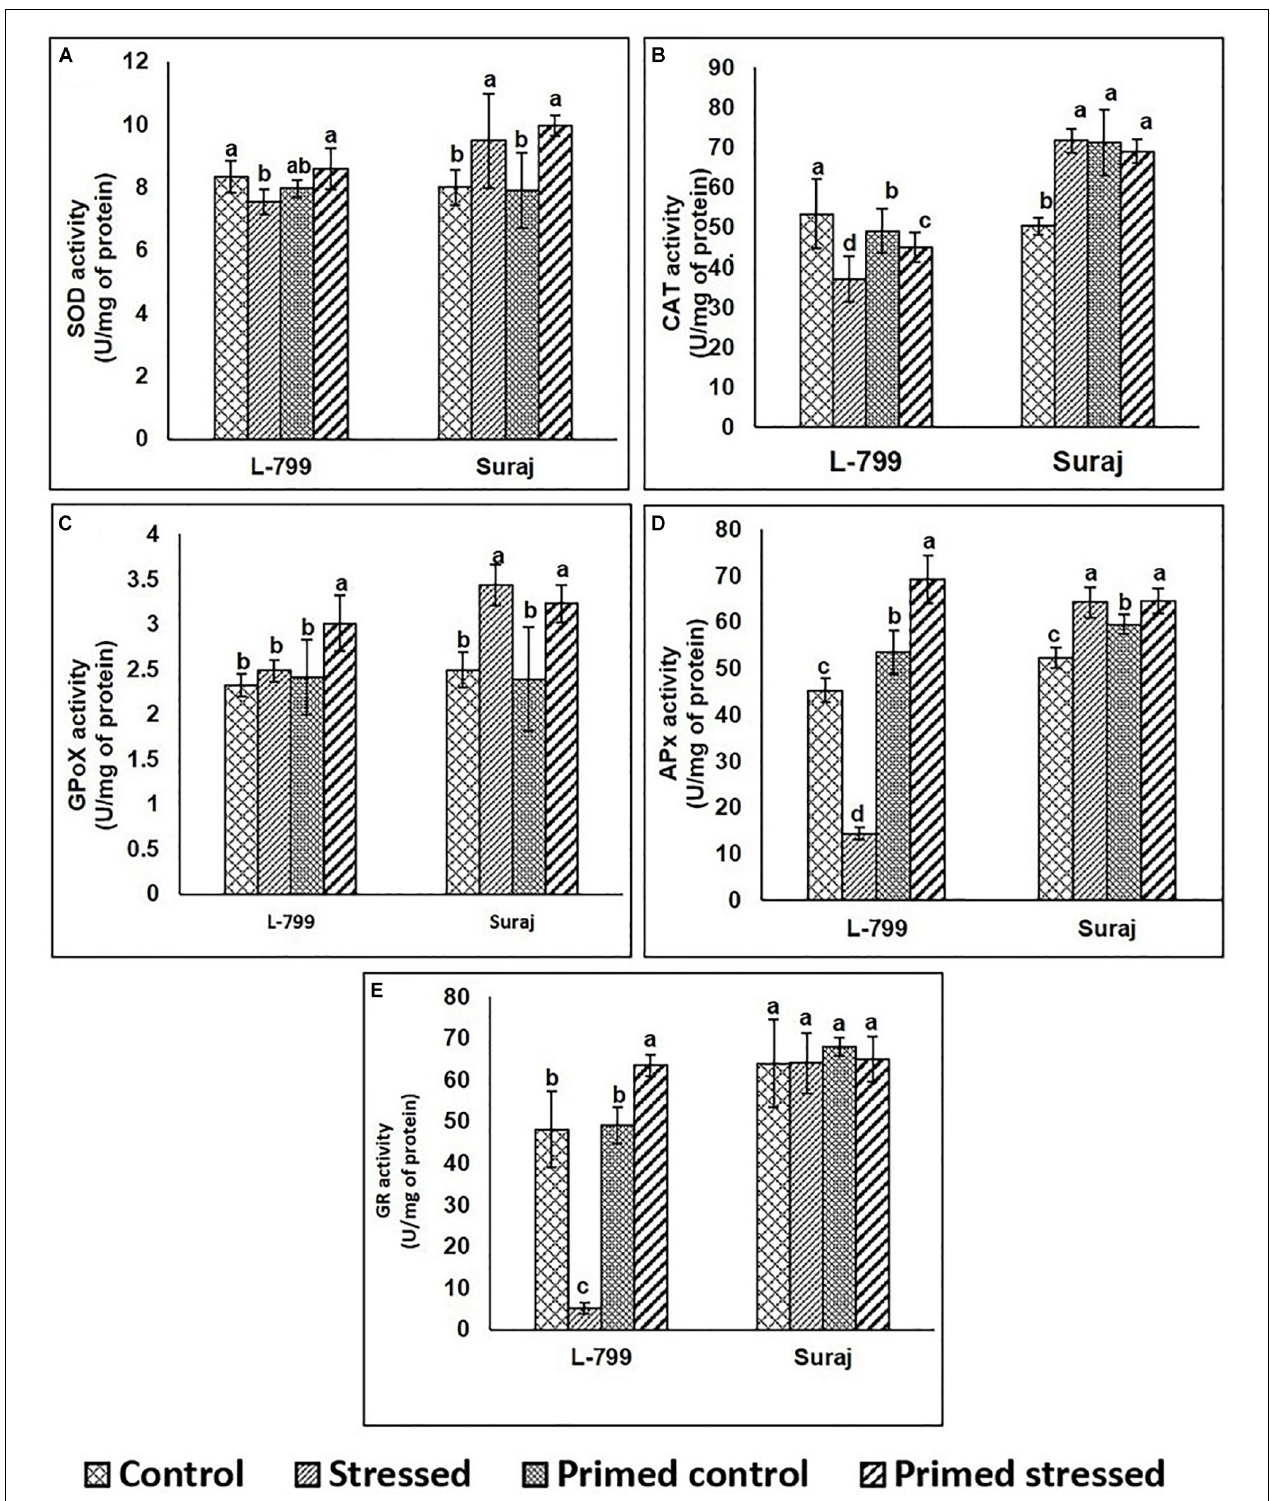
FIGURE 3 | Effect of melatonin priming on antioxidant enzyme activities in drought-tolerant and drought-sensitive varieties with and without drought stress. (A) SOD activity, (B) CAT activity, (C) GPoX activity, (D) APx activity, and (E) GR activity. Data represent mean values ± SD of 3 independent experiments, with 3 replicates per treatment in each experiment. Different alphabets within the group represent significant differences among treatments according to Duncan multiple range test at P < 0.05.